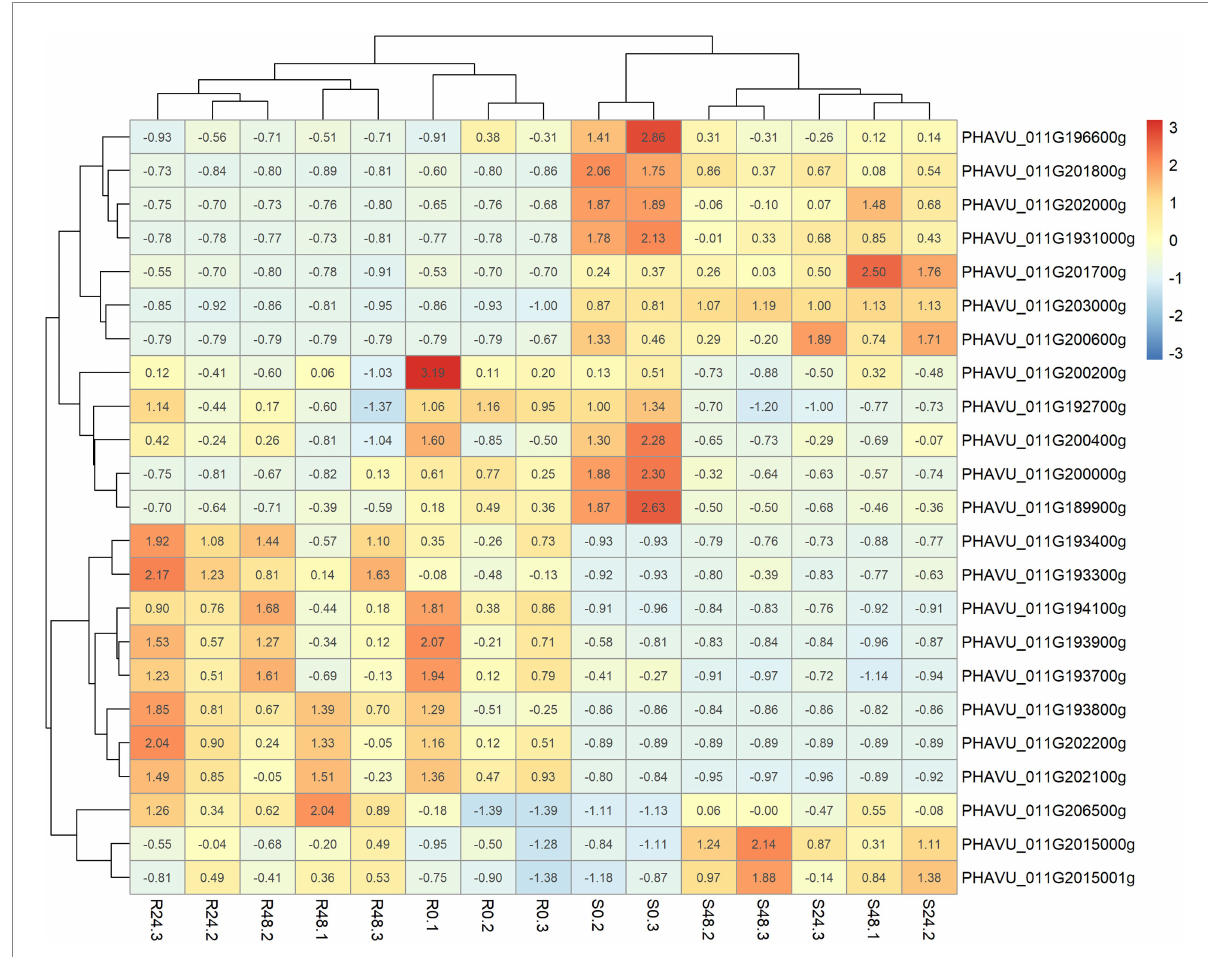
FIGURE 3 Heatmap built with the package pheatmap showing the expression (FPKM) for the resistant and susceptible lines (A4804 & A25) per hour post- inoculation and sample in the 23 DGEs located in the delimited region introgressed with the resistance to C lindemuthinanum race 38 in the genotype